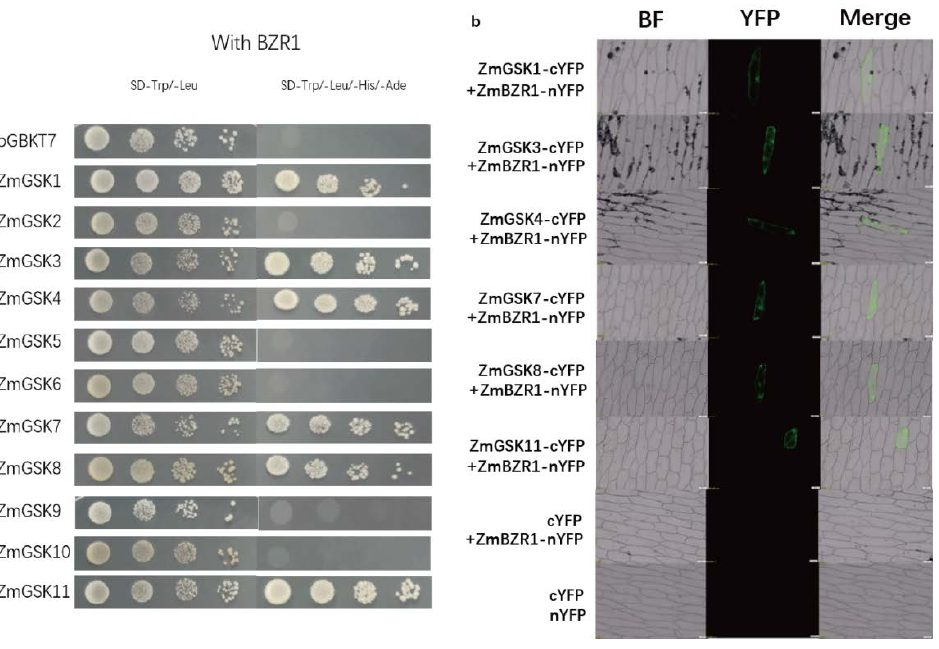
Figure 6. Results of protein–protein interaction assay of ZmGSKs and ZmBZR1. ( a ) Results of yeast two-hybrid assays. Saccharomuces cerevisiae strain AH109 was co-transformed with the indicated combinations of pAD-BZR1 and pBD-GSKs. The clones were first isolated on SD/-Trp/-Leu plates. Then, the transformed yeast colonies were grown on selection medium plates (SD/-Trp/-Leu/-His/- Ade). ( b ) BiFC-analysis results. Fluorescence was observed in the transformed cells, which resulted from the complementation of the C-terminal part of YFP fused with ZmGSKs (ZmGSKs–cYFP) with the N-terminal part of YFP fused with ZmBZR1 (ZmBZR1–nYFP).